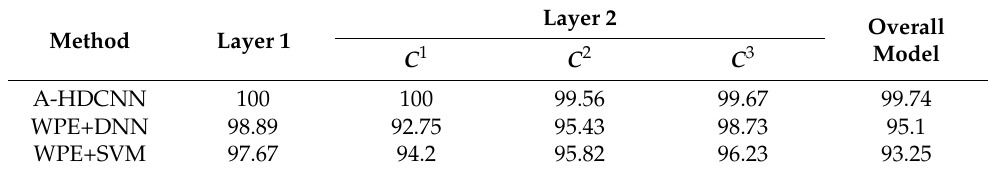
Table 7. A-HDCNN model diagnostic accuracy of each layer compared with existing methods.